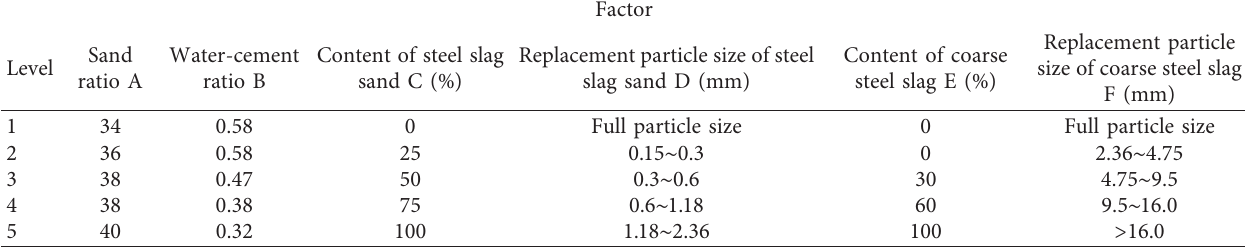
Table 2: The quantitative levels of each parameter [30, 31].